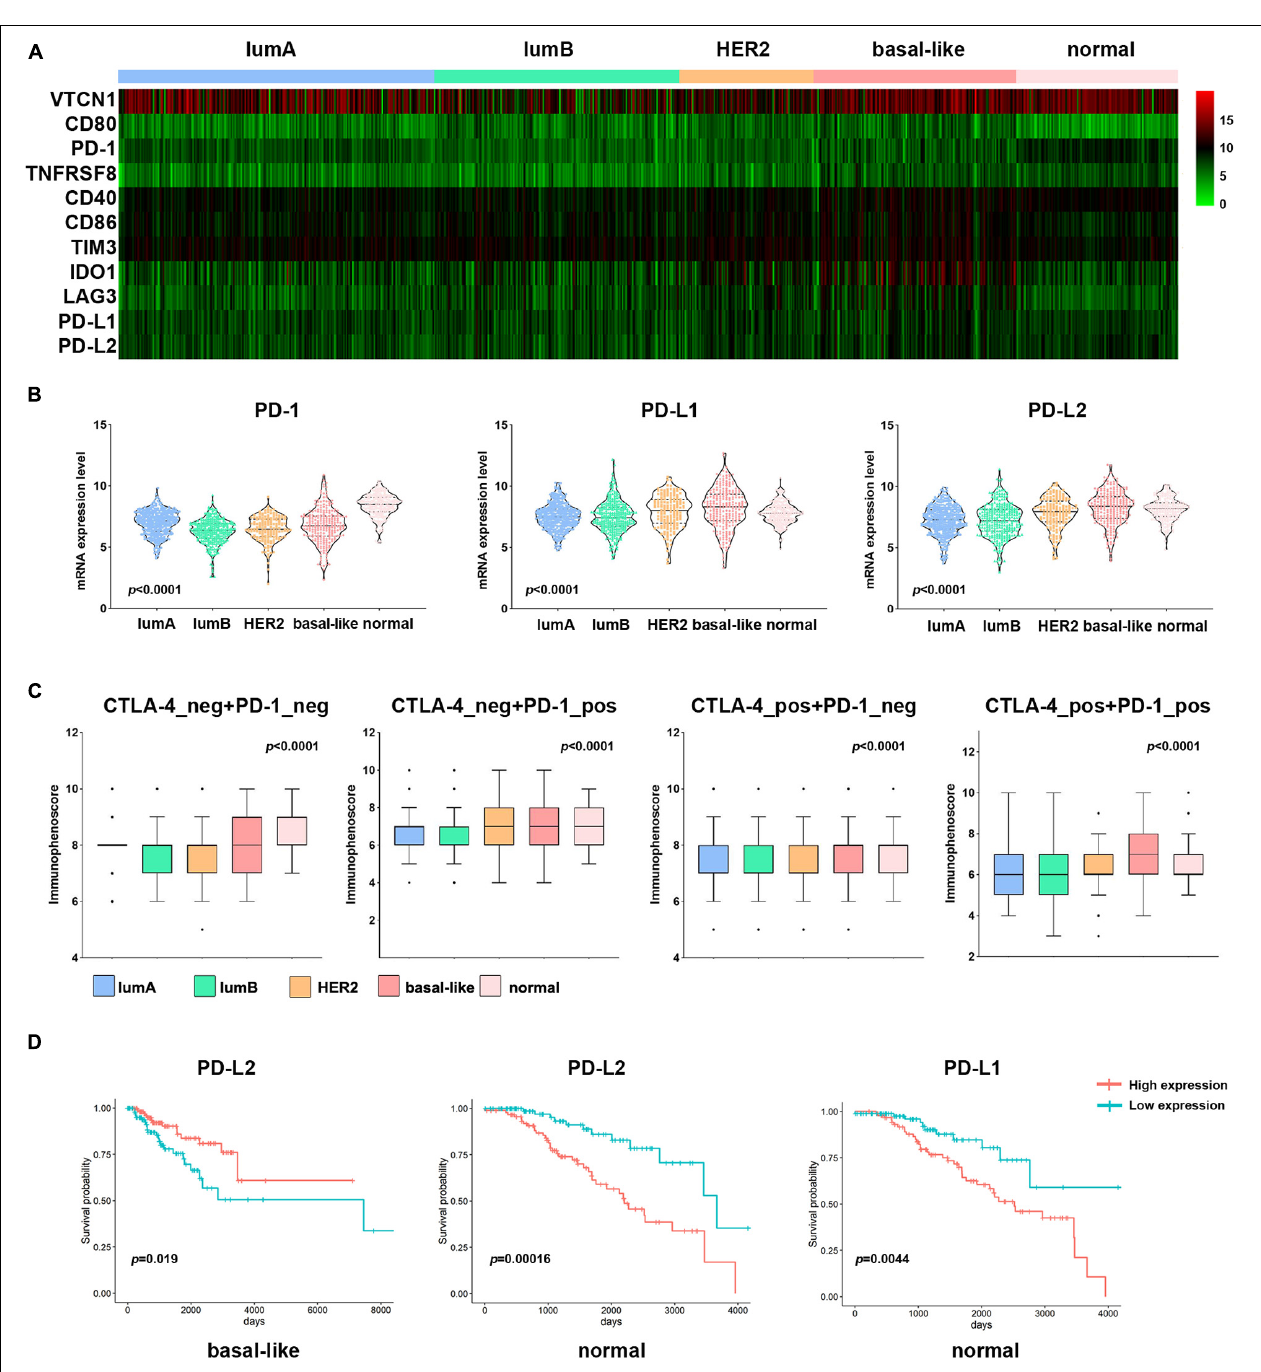
FIGURE 7 | Association of PD-L1 expression and IPS among subtypes in patients with breast cancer. (A) Heatmap representation of differences in mRNA expression levels of immune inhibitory checkpoint-related genes. (B) Comparison of PD-1, PD-L1, and PD-L2 expression levels between each subtype in breast cancer. (C) IPS comparison between each subtype in breast cancer patients in the CTLA4-negative/positive or PD-1-negative/positive groups. CTLA4-positive or PD1-positive represented anti-CTLA4 or anti-PD-1/PD-L1 therapy, respectively. (D) Kaplan–Meier survival curves of PD-L1 and PD-L2 in different breast cancer subtypes. Red represents the high expression group, and blue represents the low expression